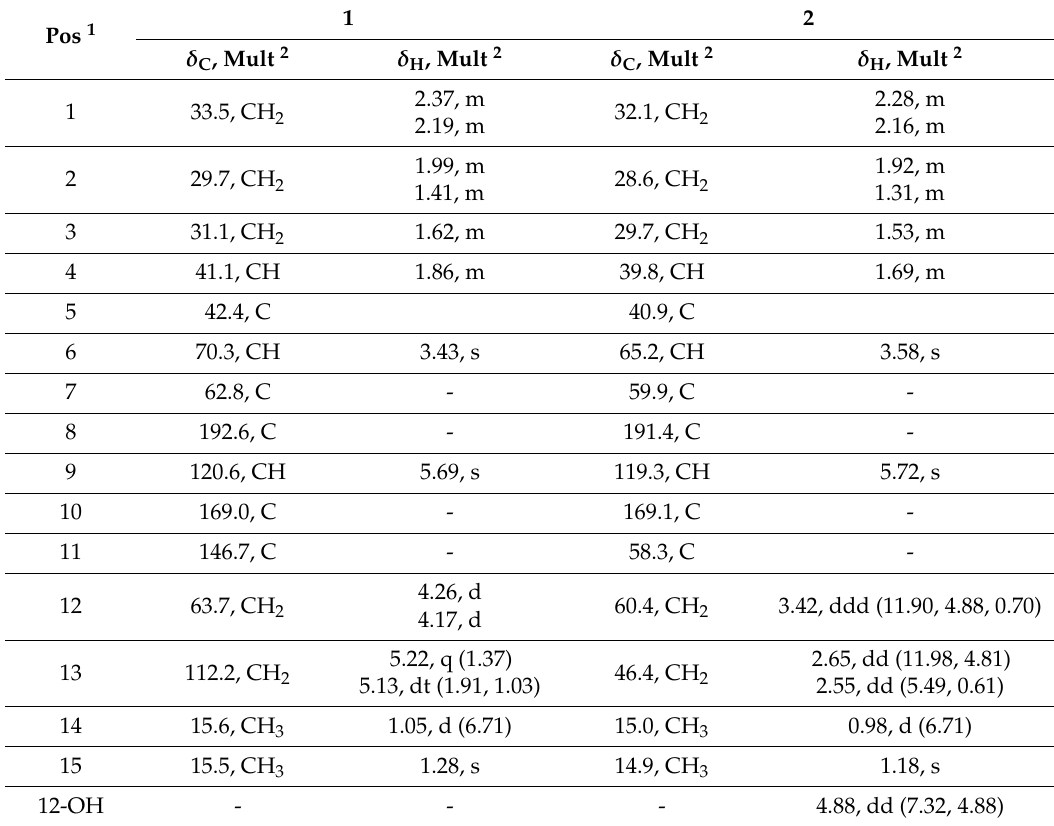
Table 2. One-dimensional (1D) NMR data of phoenixilanes A–B ( 1 – 2 ) ( 1 : acetone- d 6 , 2 : DMSO- d 6 ; 1 H NMR: 500 MHz, 13 C NMR: 125